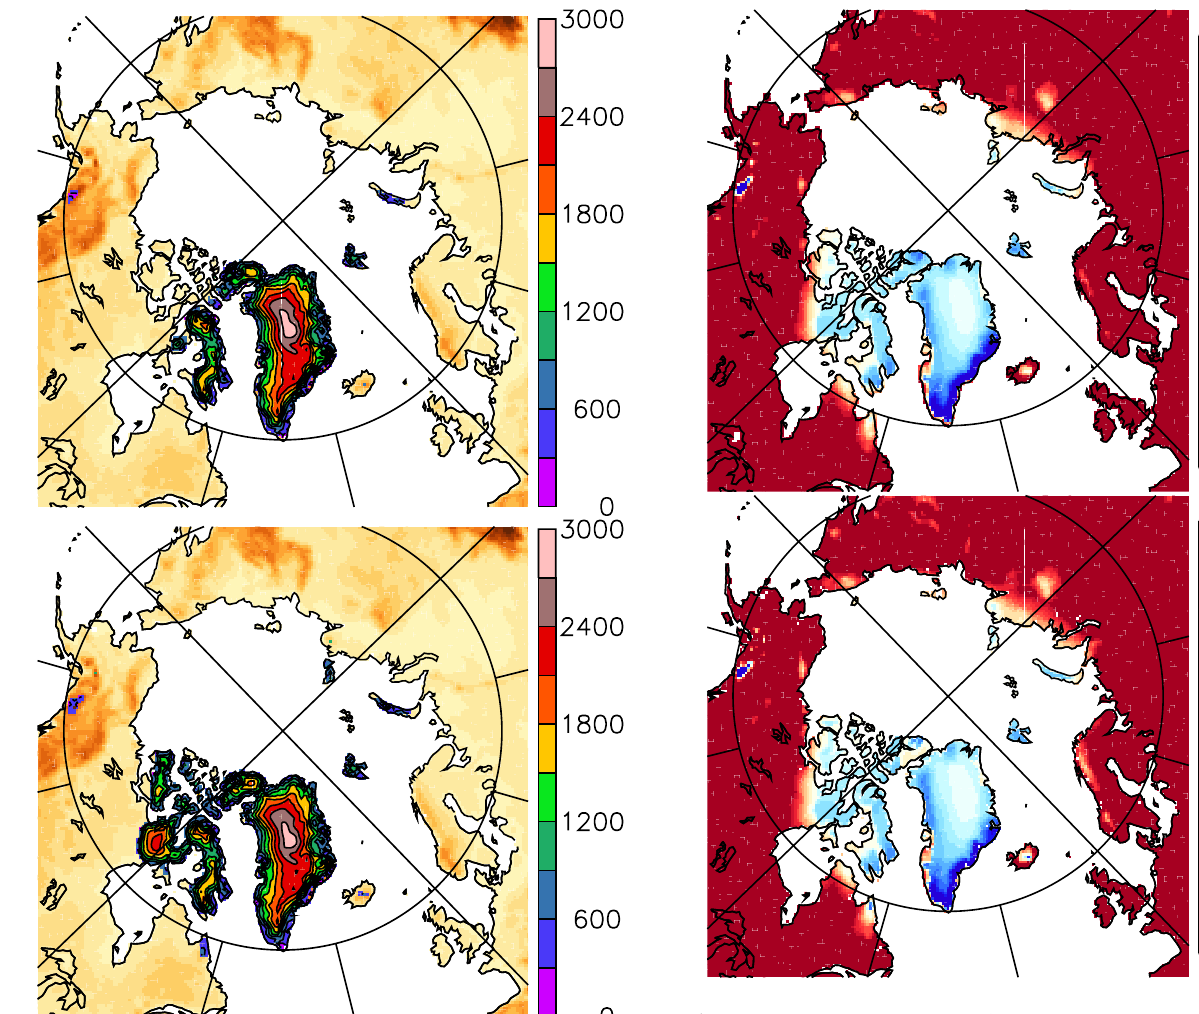
Fig. 3. Upper: mass balance of the 115ka control experiment, forced by a 100 year average of the climate model, in myr − 1 . Lower: as above, but forced by an average of the 40 years of coldest summers over Scandinavia in the same model experiment (see Fig.